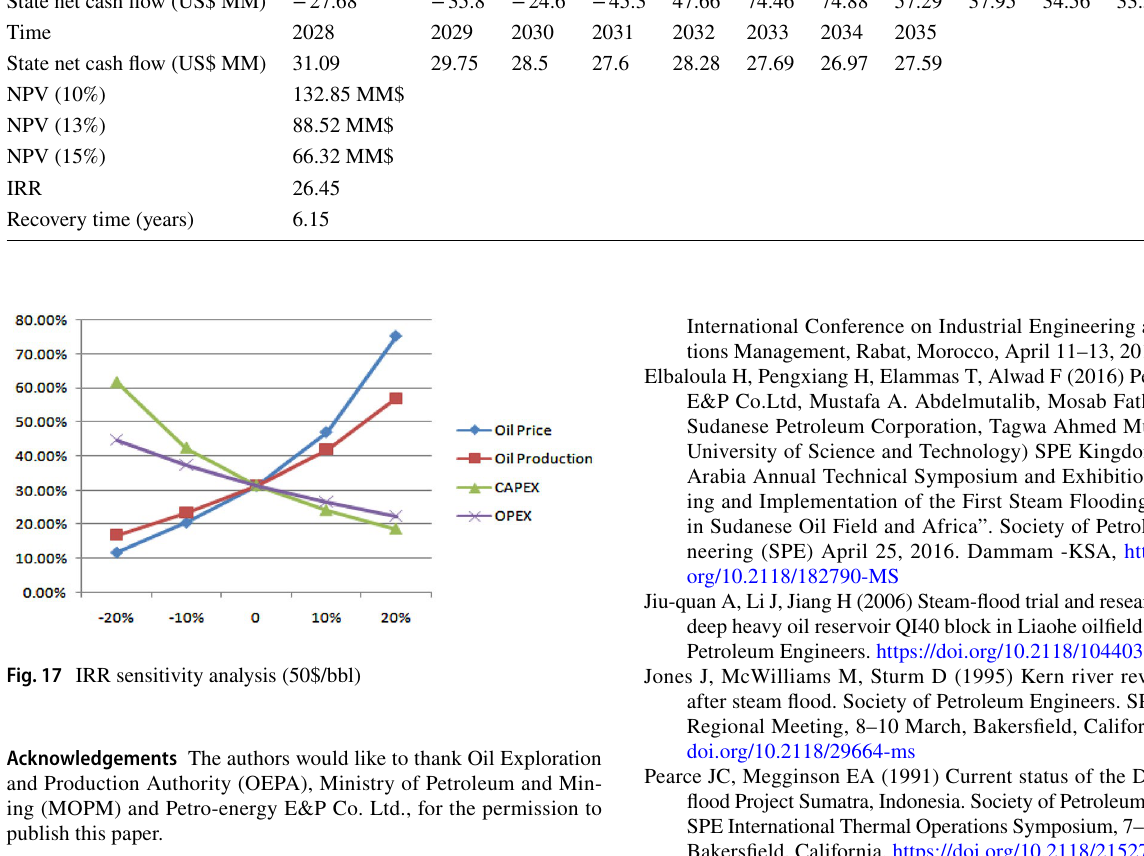
Table 20 The net cash flow for the contractor (50$/bbl) Time